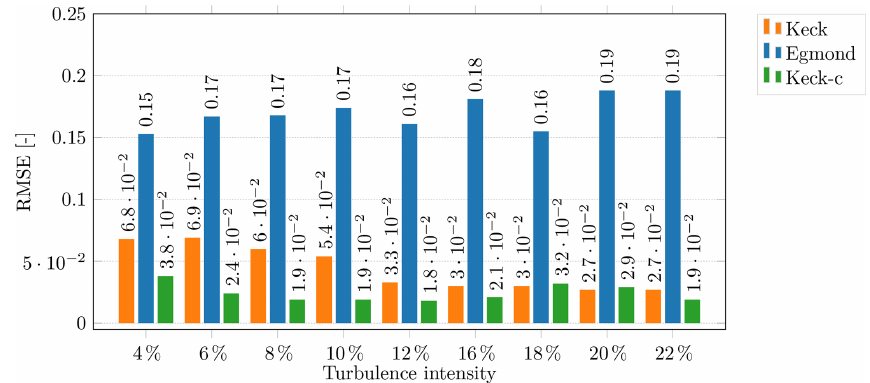
Figure 14. RMSE between the lidar-measured and the simulated normalized minimum wind speed in the wake.